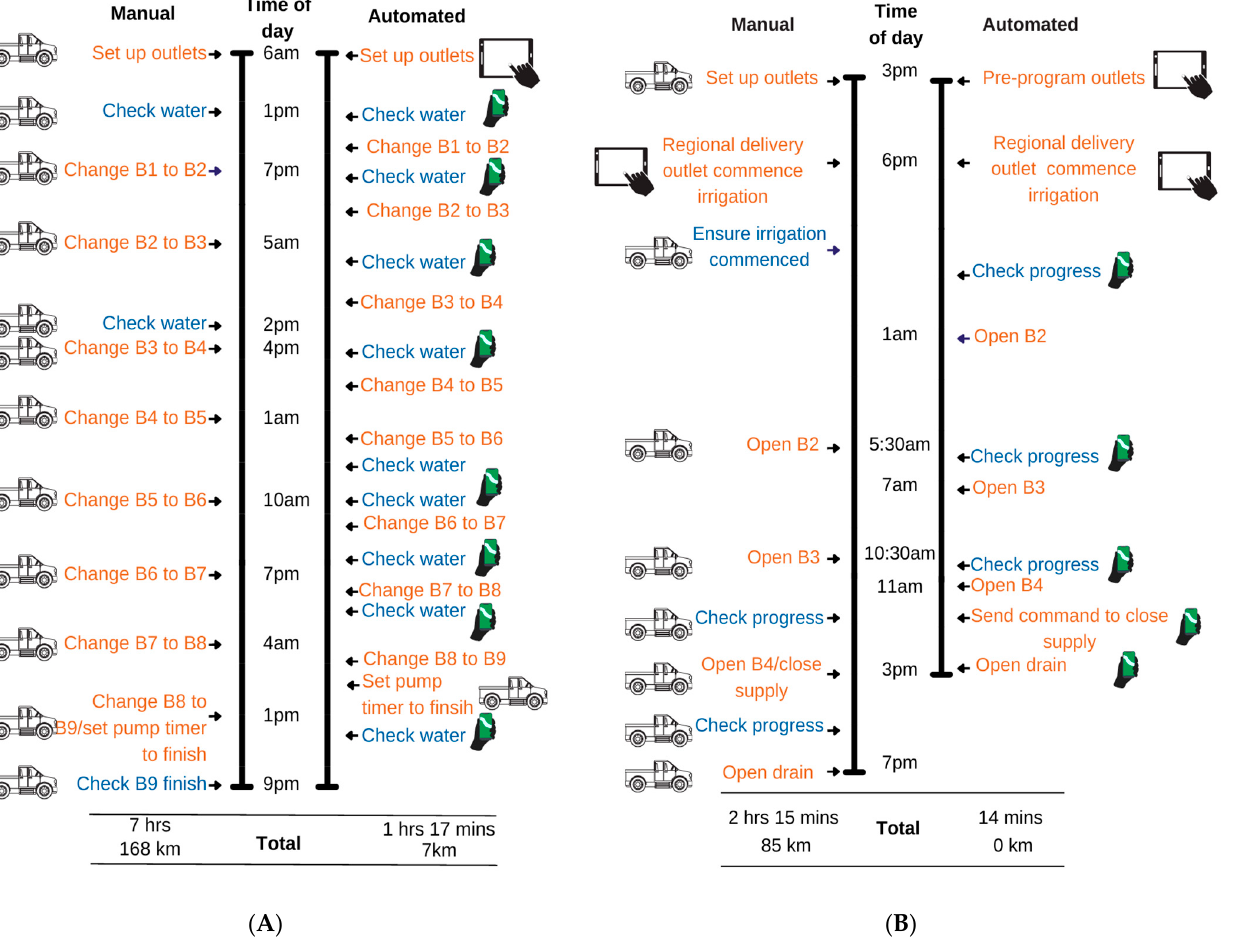
Figure 5. ( A ) Time and travel associated with manual flush irrigation at Site A. ( B ) Time and travel associated with flush irrigation of manual and automated fields at Site B. Essential activities are indicated in orange, whilst non-essential water checks in blue. “Water checks” were often occasions when the farmer went to close the inlet of one bay and open the next inlet, but irrigation was not complete and was required to return later.